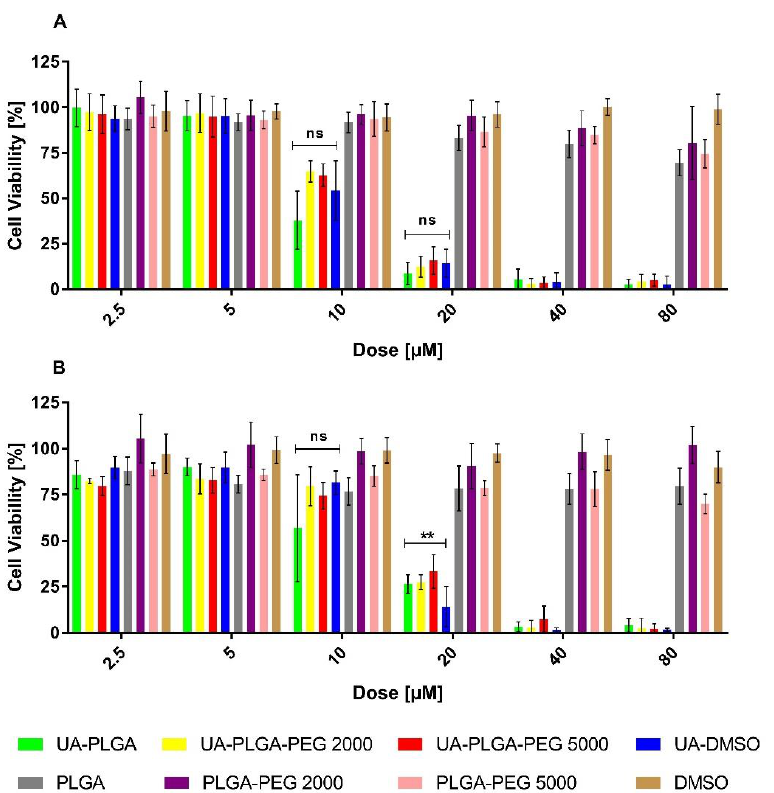
Figure 5. Cytotoxic effect of ursolic acid encapsulated in PLGA nanoparticles or in the free non- encapsulated form in DMSO, determined by the MTT assay, after 72 h of incubation, for AsPC-1 ( A ) and BxPC-3 ( B ) cell lines. For points 20 μM and 10 μM statistical significance between free and loaded compound was evaluated by Graphpad Prism 7 and was shown, as stars (**) represents significant difference, with p -value = 0.004. Ns stands for “non significant”.